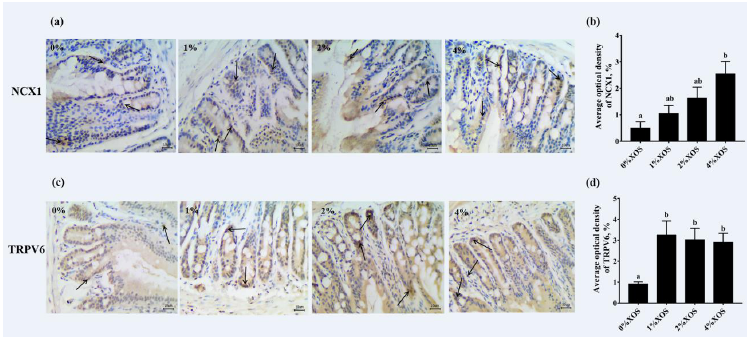
Figure 1. Effects of xylo-oligosaccharides (XOS) supplementation on the Na + /Ca 2+ exchanger 1 (NCX1) ( a , b ) and transient receptor potential vanillin receptor 6 (TRPV6) ( c , d ) expression in the duodenum of the four groups. Scale bar: 10 µm. Values are means (n 8) with their standard errors represented by vertical bars. a, b Mean values with unlike letters were significantly different ( p < 0.05; Tukey post hoc